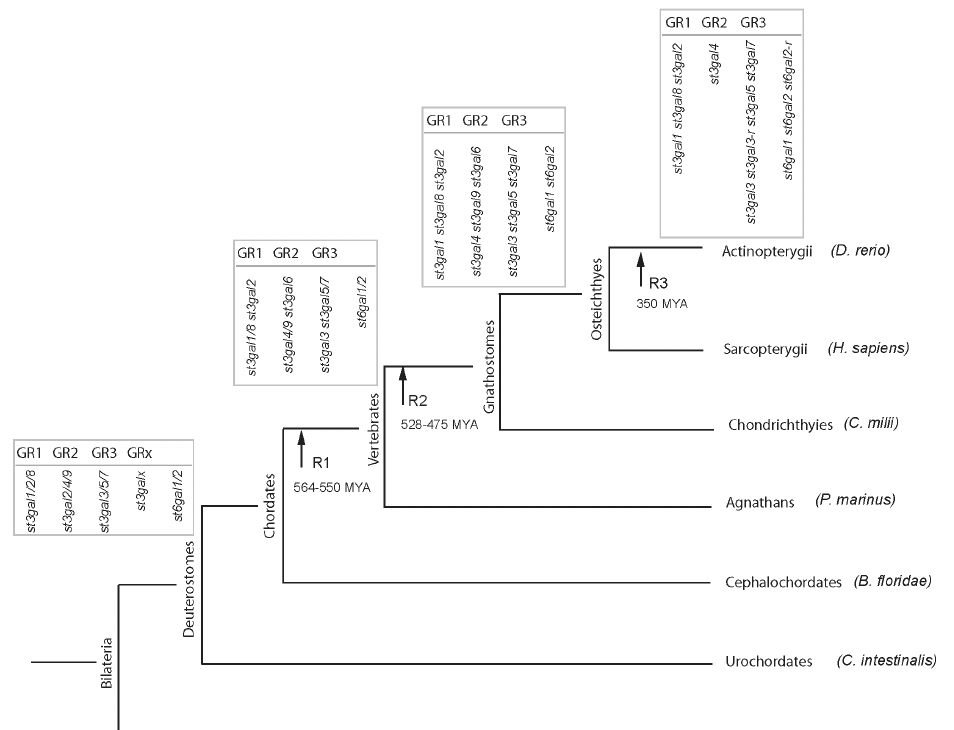
Figure 4. Hypothetical scenario of the evolutionary history of β -galactoside α 2,3/6-sialyltransferase genes in the WGR context. This drawing illustrates the proposed evolutionary scenario of st3gal and st6gal genes drawn in line with the 2R hypothesis [61]. The arrows indicate the two vertebrate whole genome duplication events (WGD-R1: ~555 MYA and WGD-R2: ~500 MYA) and the teleosts specific whole genome duplication events (WGD-R3: ~350 MYA). A single st3gal1/2/8 (GR1), st3gal3/5/7 (GR3), st3gal4/6/9 (GR2) and st6gal1/2 gene in the stem bilaterian was duplicated twice before and after the emergence of agnathans, raising 11 st3gal and st6gal subfamilies at the base of gnathostomes. 3 st3gal gene subfamilies ( st3gal7 , st3gal8 and st3gal9 ) were further lost in the mammalian lineage. In Actinopterygii, after WGD-R3 the two duplicated genes st3gal3 - r and st6gal2 - r are maintained in the zebrafish genome, whereas the st3gal6 and st3gal9 genes are secondarily lost. S. purpuratus = Strongylocentrotus purpuratus ; C. intestinalis = Ciona intestinalis ; B. floridae = Branchiostoma floridae ; P. marinus = Petromyzon marinus ; C. milii = Calorhinchus milii ; D. rerio = Danio rerio .